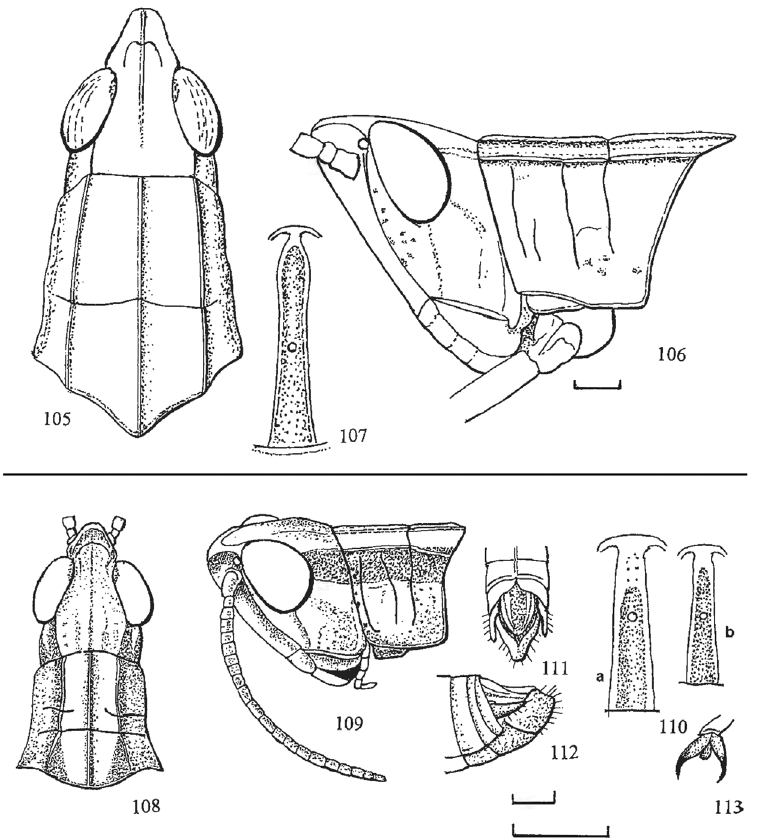
Figs 105–113. Duronia genus group. Figs 105–107. Duronia chloronota phippsi n. subsp .: 105, 106. Head and pronotum dorsally and from left side, respectively; 107. Frontal ridge. Figs 108–113. Duroniella acuta Uvarov: 108, 109. Male head and pronotum from above and oblique view, respectively; 110. Frontal ridge A. Male; B. Female; 111. Male abdominal apex from above; 112. Male abdominal apex from oblique aspect, left side; 113. Tip of hind tarsus showing small pulvillus. All scale lines represent 1 mm: of two scales under Fig. 112, only uppermost applies to Figs 105–112, while lowermost applies to Fig.